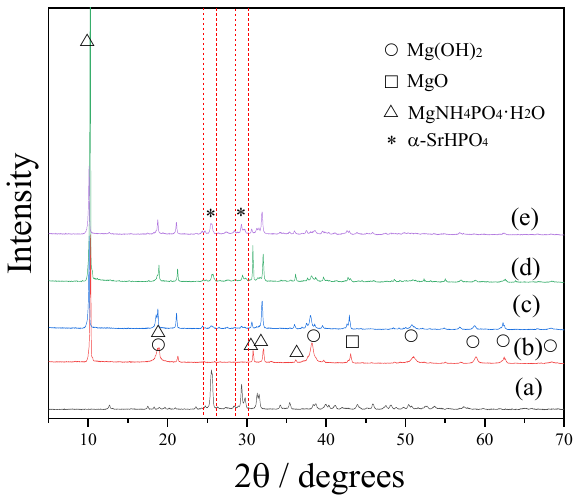
Figure 2. XRD patterns of α-SrHPO4 ( a ) and porous composite scaffolds S0, S1, S3, and S5 (( b – e ), respectively), with increasing SrHPO 4 contents. The diffraction peaks of α-SrHPO 4 are marked by the red dotted lines.